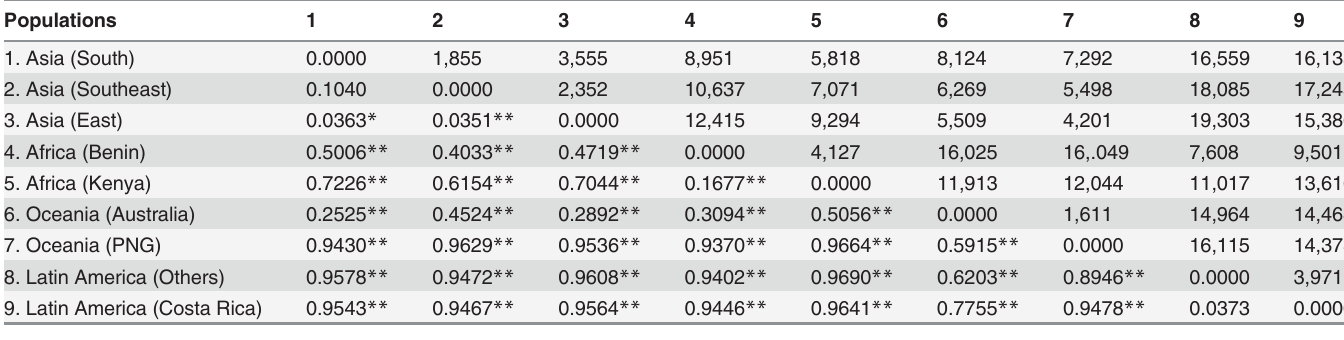
Table 5. Pairwise FS T values (below diagonal) and distance matrix (above diagonal; in the unit of kilometer) comparing populations of Maruca vitrata (continent or larger geographical region based